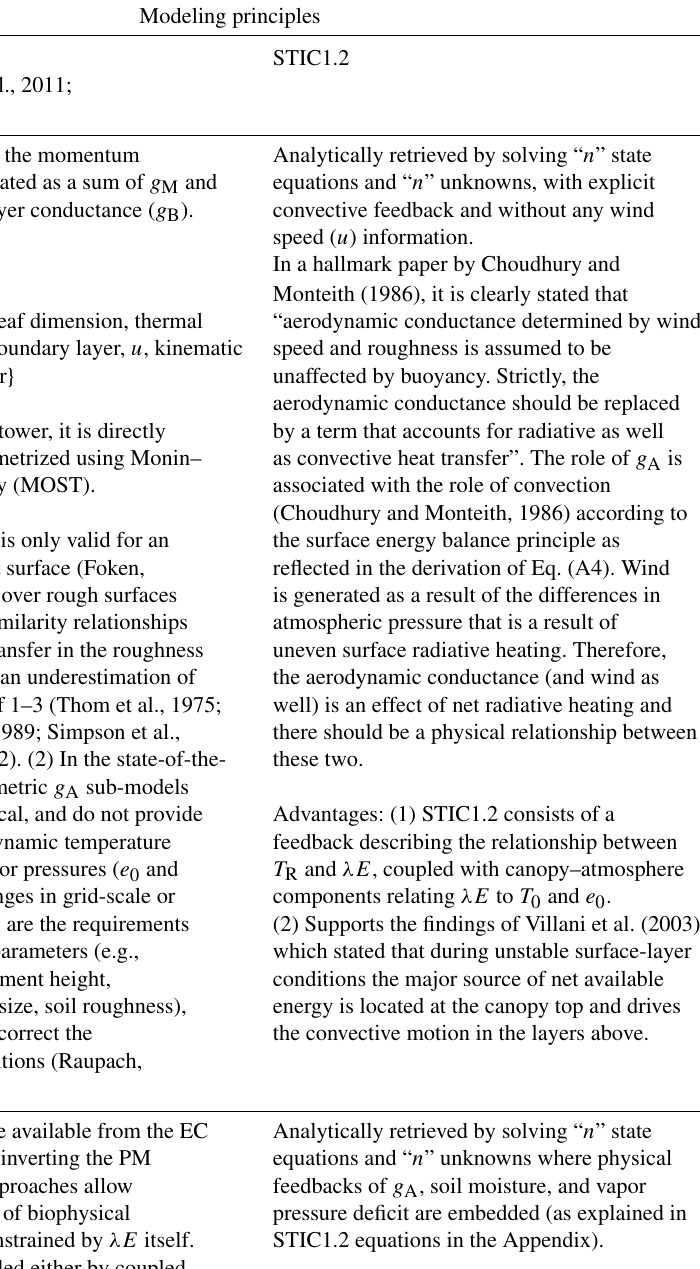
Table A2. Fundamental differences in the modeling principles between STIC1.2 and previous approaches for characterizing the biophysical controls on λE